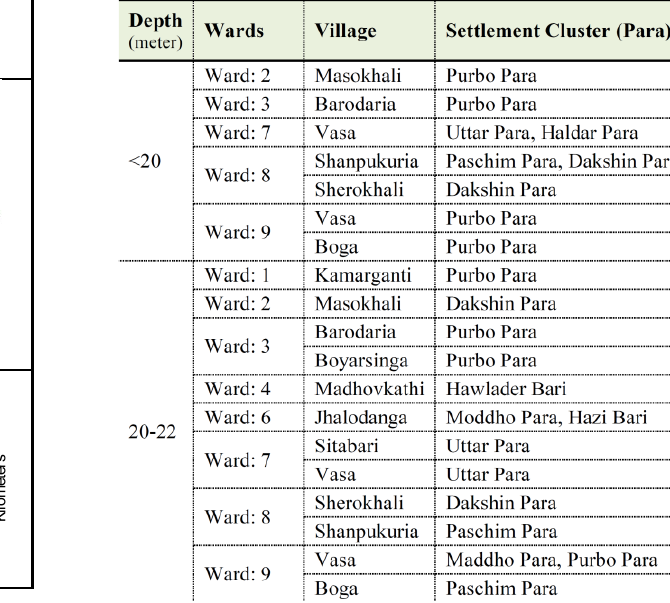
Figure 5. Suitable arsenic-safe aquifer in